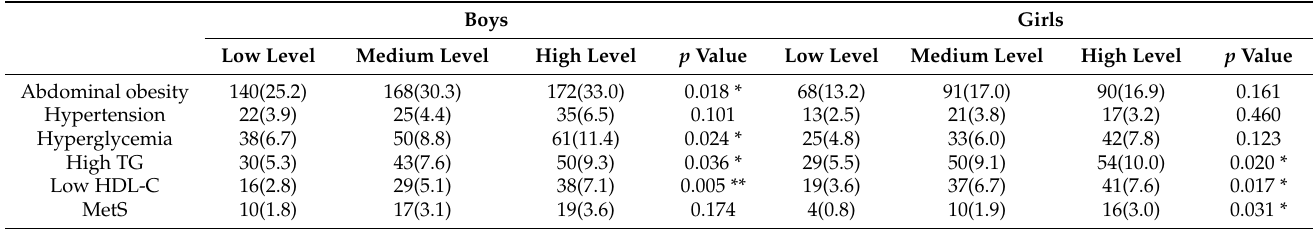
Table 2. Prevalence of MetS components in different sedentary behavior time groups by gender #.